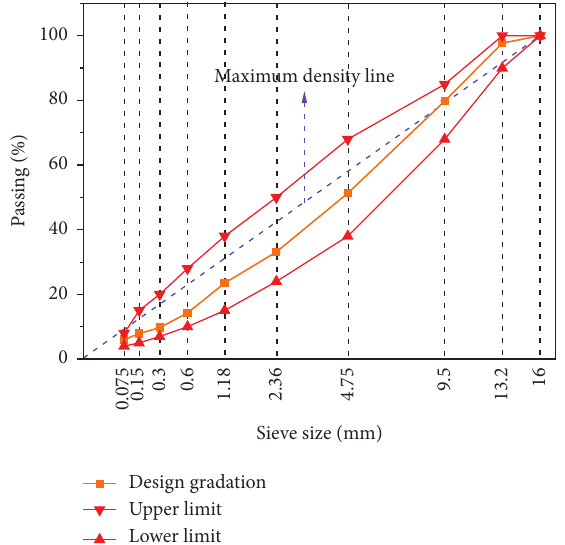
Figure 2: Design gradation of the asphalt mixture.